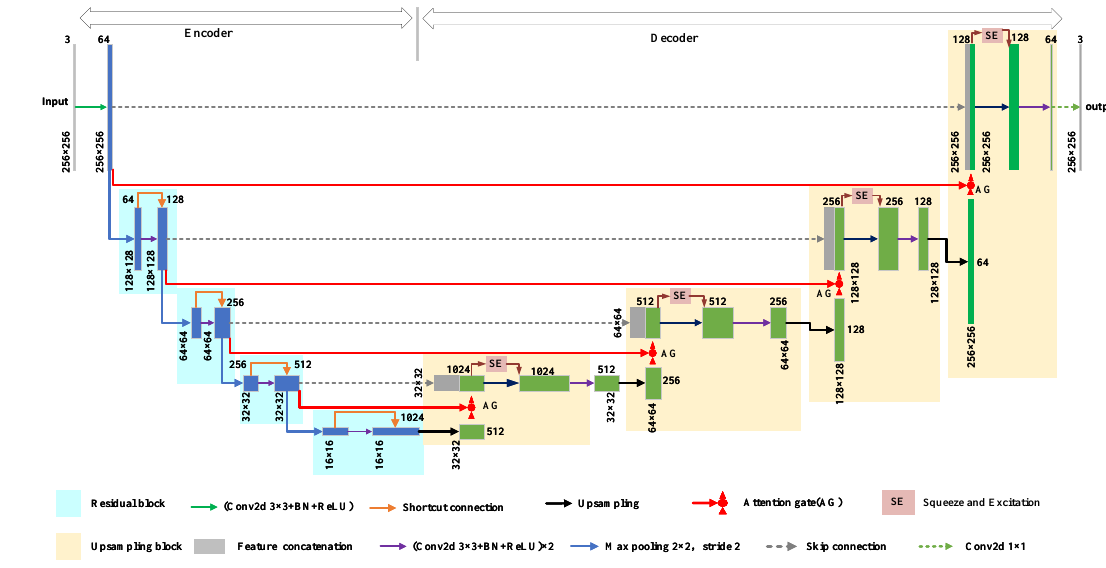
Figure 4. The architecture of the DAttRes-Unet